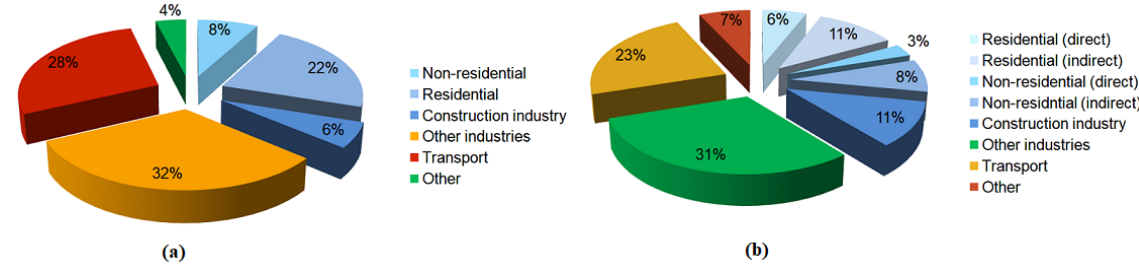
Figure 1. Global share of buildings and construction final energy and emissions, 2018 ( a ) energy consumption ( b ) emissions [10].